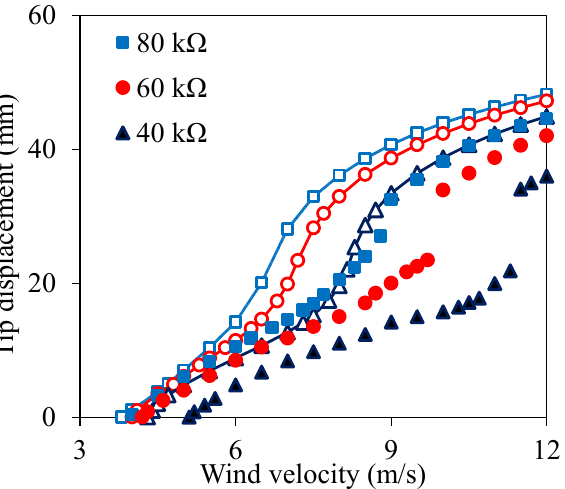
Figure 10. Variation of the tip displacements with wind velocity for different external load resistances (solid symbols: measured; lines with empty symbols: simulated).